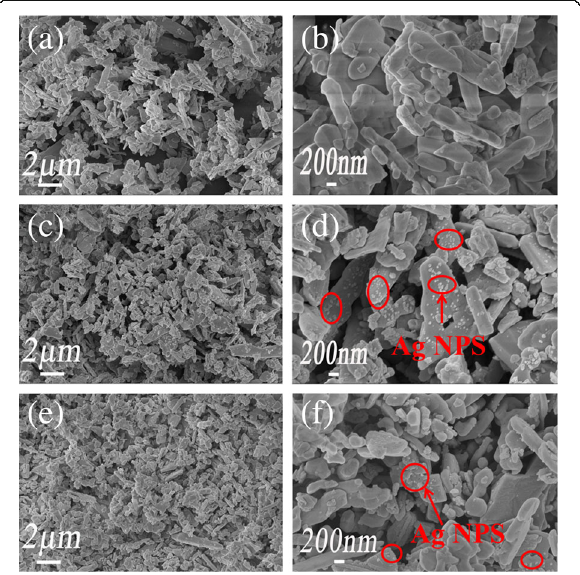
Fig. 3 SEM images. a , b Low- and high-magnification images of pure BiVO. c , d Low- and high-magnification images of the Ag/BiVO 4 composite. e , f Low- and high-magnification images of the Ag/BiV 0.9925 Mo 0.0075 O 4